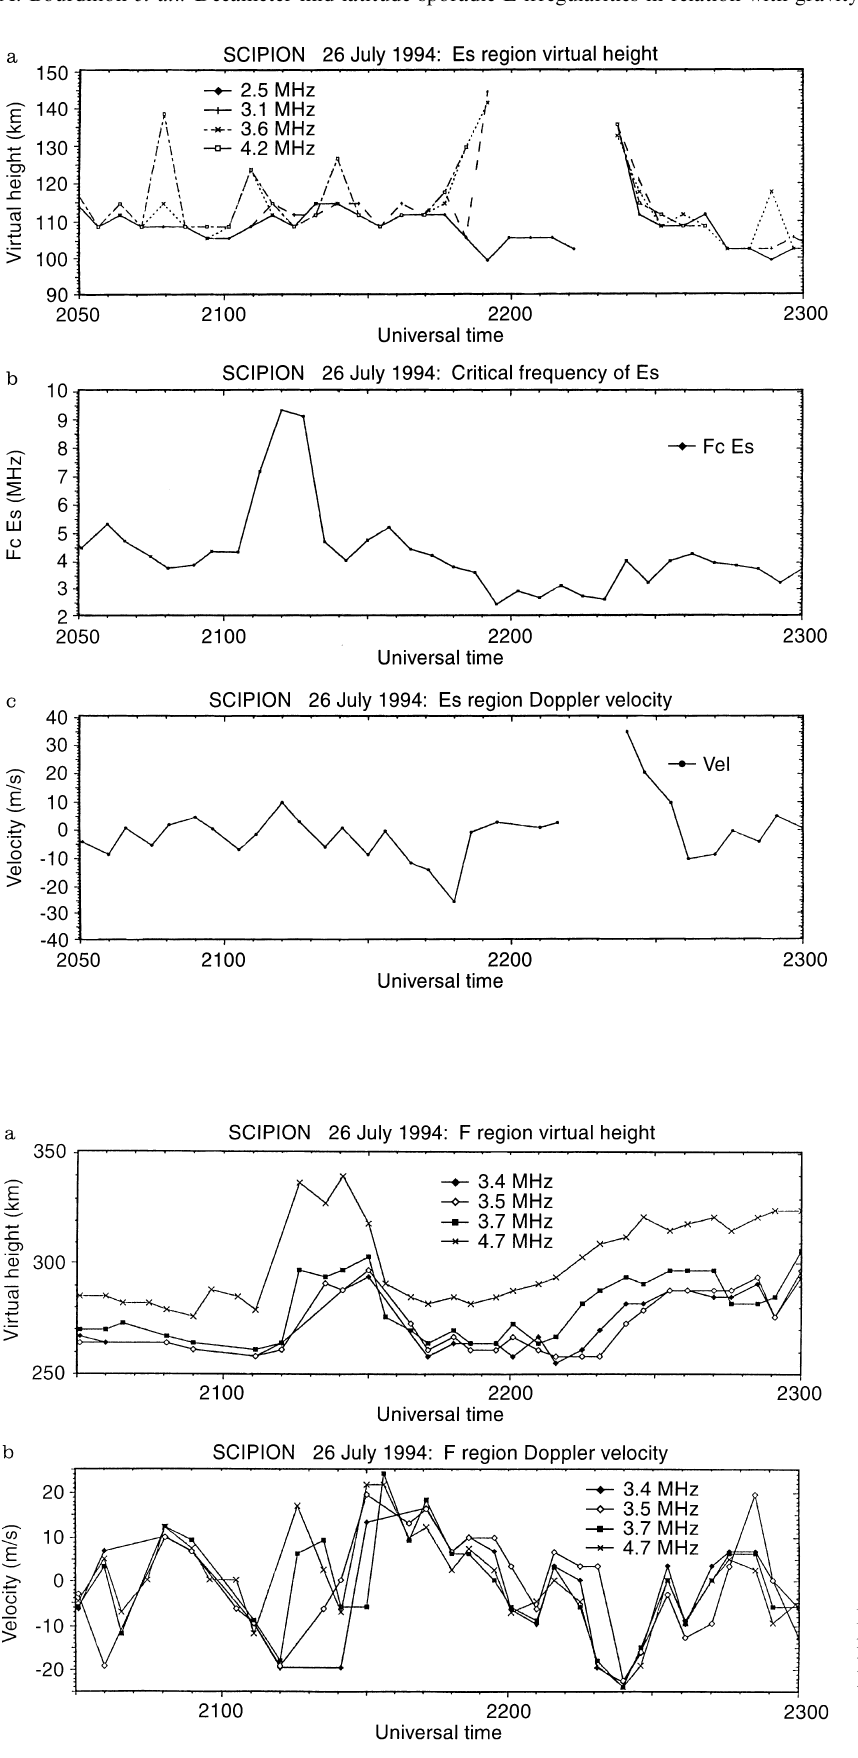
Fig. 8a,b. Data from vertical sounding measurements of F-region echoes: a virtual height and b Doppler velocity both